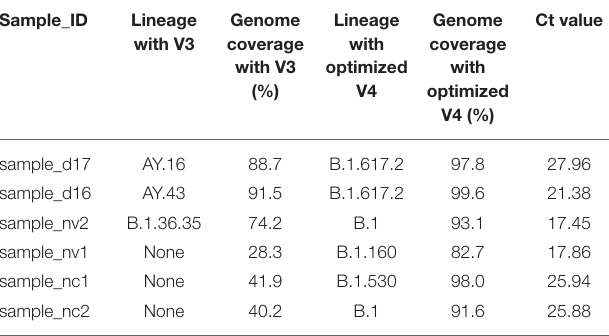
TABLE 1 | A table showing changes in lineage assignment and genome completeness among discrepant